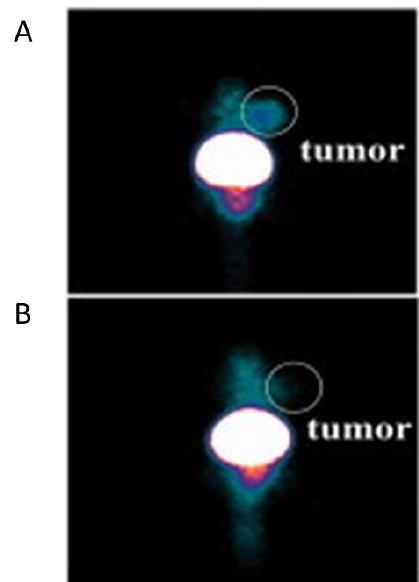
Figure 5. SPECT images of C6 xenograft tumor bearing mice after 3 days of DOX treatment at 8 h post tracer injection: in ( A ), mice were injected with 9m Tc-duramycin-Au DENPs, in ( B ) with 99m Tc-Au DENPs [35].